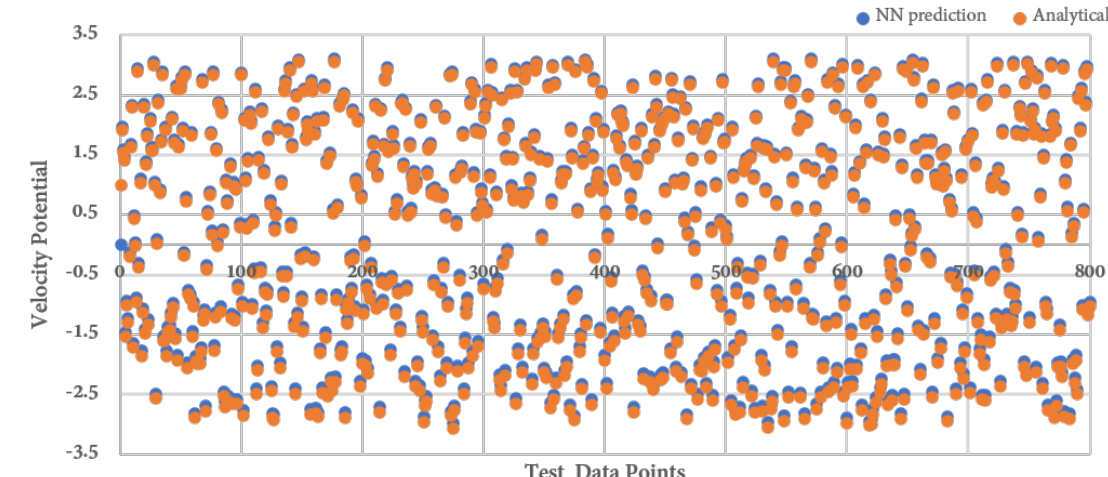
Figure 6. Velocity potential comparison between predicted and analytical results. The blue and orange dots denote the neural network predicted results and the analytical results. The horizontal axis shows the number ID of sampled points and vertical axis is the value of velocity potential.